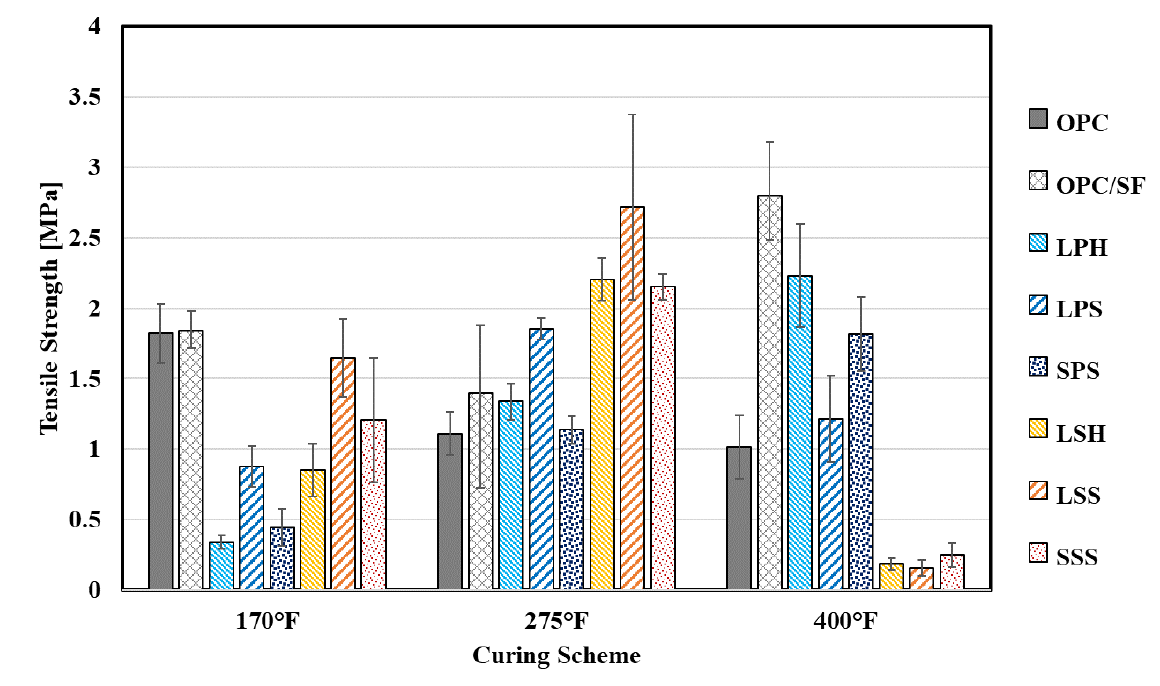
Figure 3. Three-day tensile strength for OPC and geopolymer formulations cured with different curing schemes (indicated by BHST value, see Table 3). Error bars represent the range of tensile strengths values measured for each mixture.